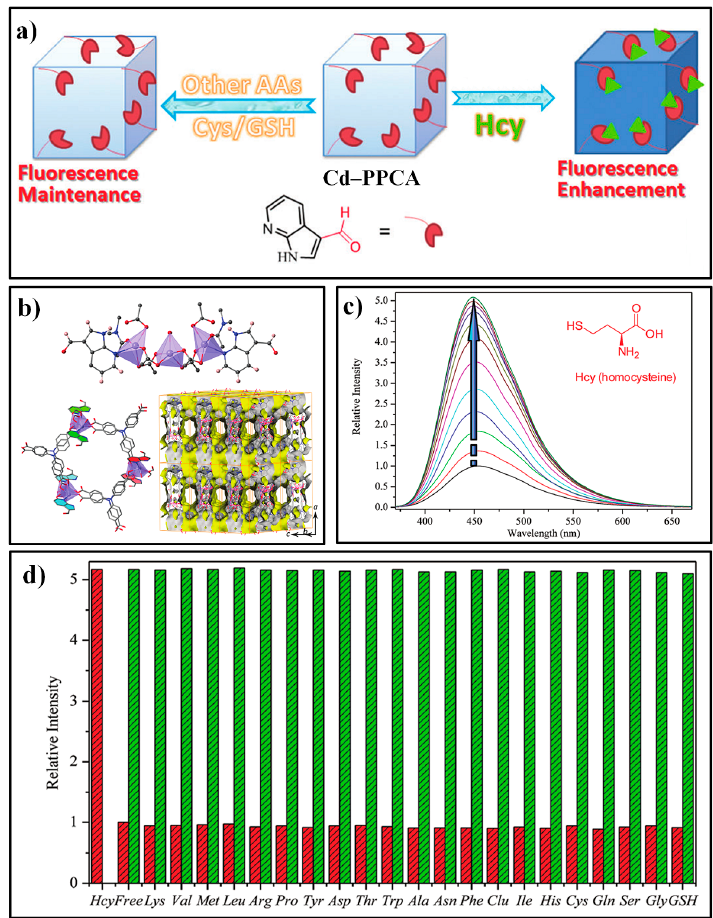
Figure 10 . ( a ) The fluorescence detection mechanism of Cd–PPCA for Hcy. ( b ) the coordinated environment of the Cd 2+ in Cd–PPCA (Top); a two-dimensional double-layer structure composed of Cd 2+ and ligands of ppca and H 3 tca (bottom-left); the Connolly surface of the framework of Cd–PPCA (bottom-right). ( c ) The fluorescence spectra of Cd–PPCA upon addition of different amounts of Hcy. ( d ) Results for selectivity and competition tests. Reproduced with permission from [100]. Copyright the Royal Society of Chemistry, 2018.